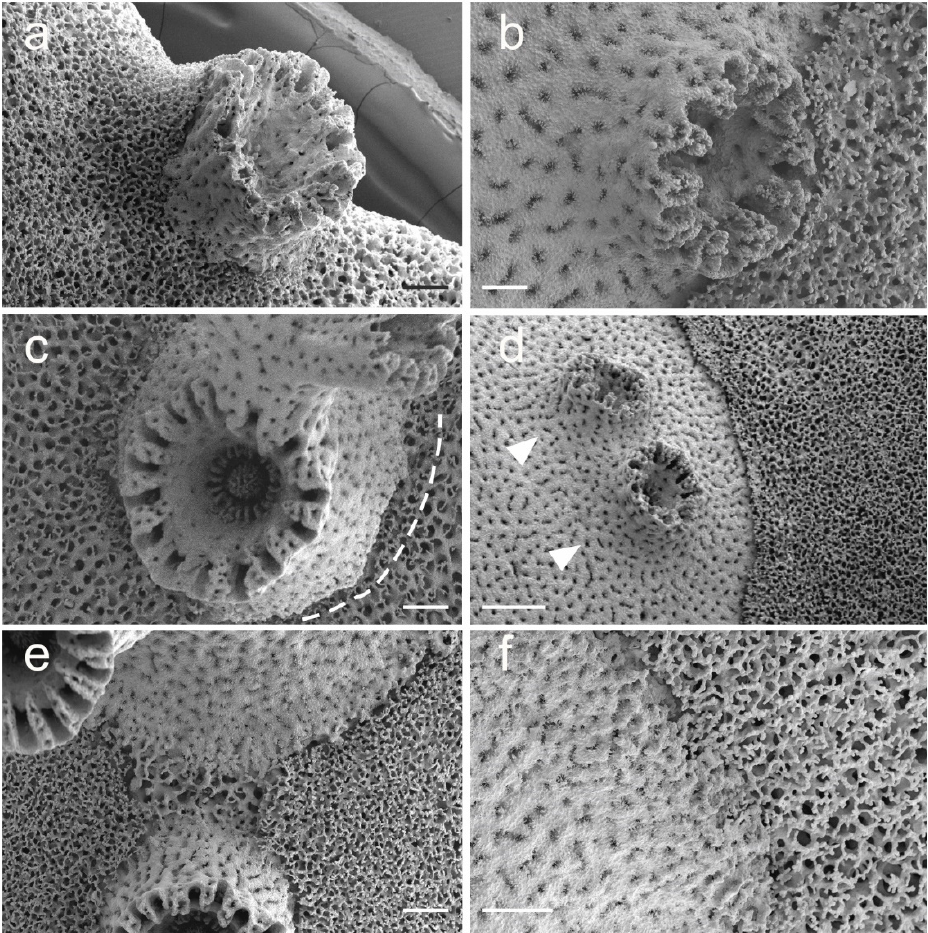
Figure 4. SEM analyses revealed ( a , b ) the capacity of Millepora alcicornis to overgrowth Stylaster roseus ; ( c , d ) the capacity of S. roseus to overgrowth on M. alcicornis ; ( e , f ) the apparently intimately connection of both skeletons in some parts of the associations. (Scale bars: a–c ⁓ 100µm; d ⁓ 200 µm; e–f ⁓ 100 µm).